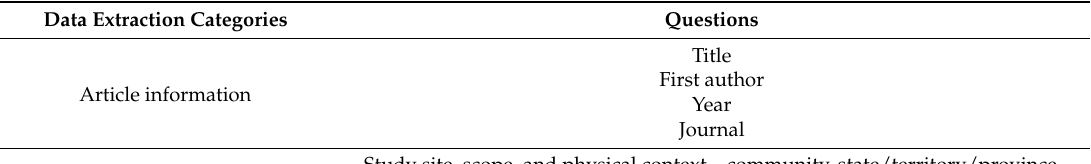
Table A1. Coding form for qualitative analysis and synthesis of the 85 included articles that described integrated environment and health surveillance in Circumpolar Arctic and Subarctic regions.